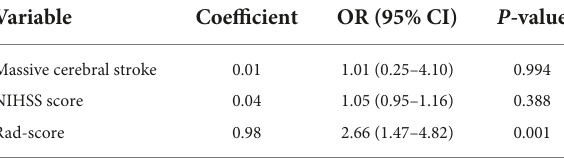
TABLE 2 Multivariate logistic regression analysis of independent risk factors for hemorrhagic transformation (HT) in the training cohort.